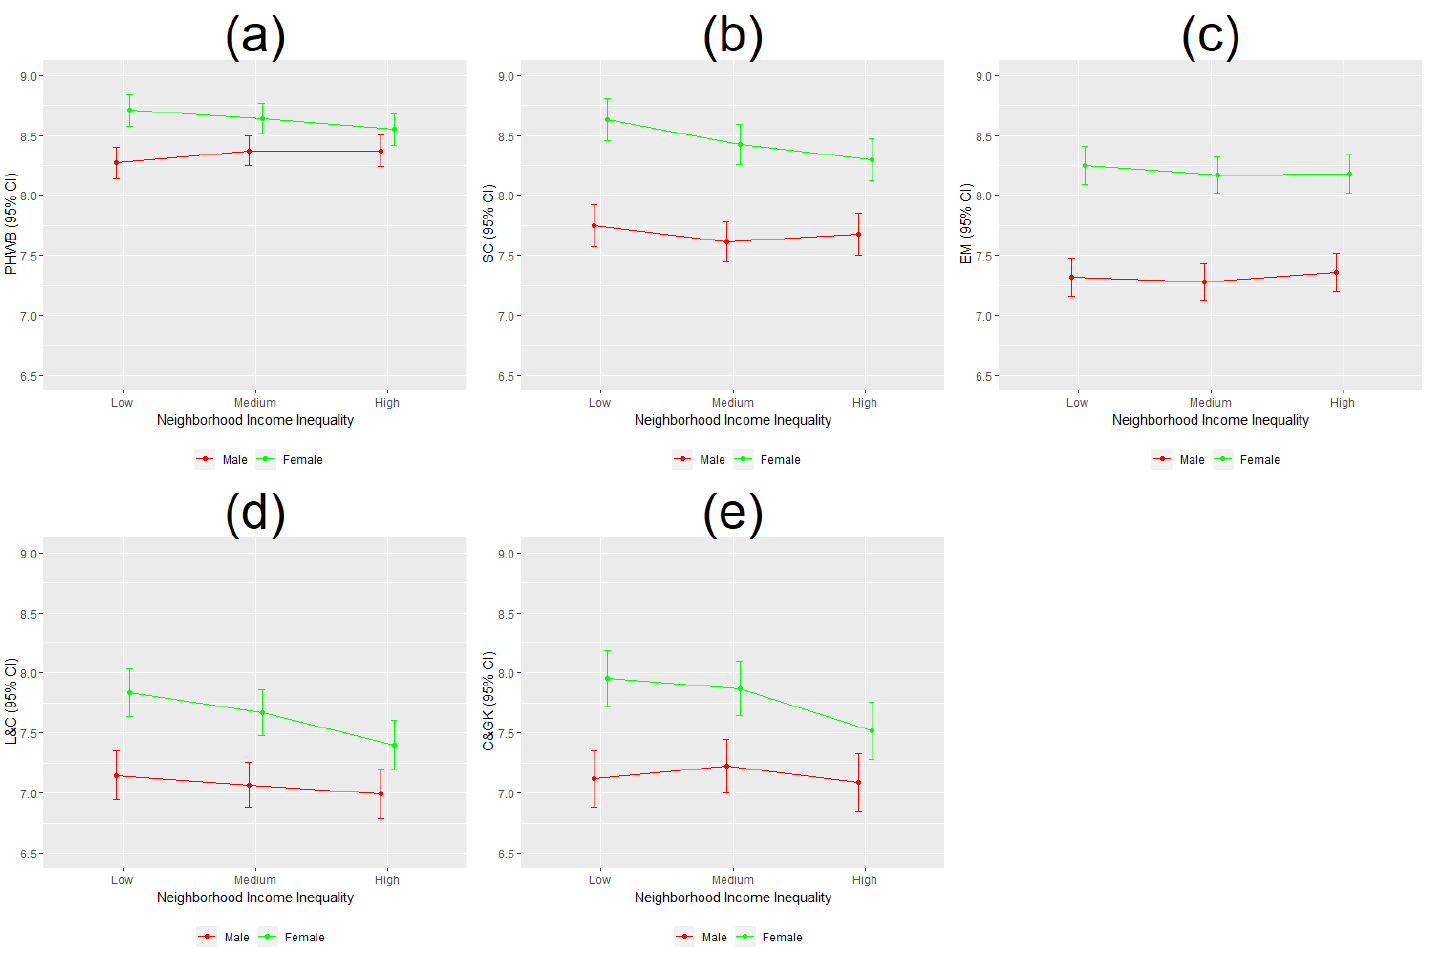
Figure 4. Predicted EDI scores by neighborhood income inequality and children’s sex. ( a – e ) show the relationship between low, medium and high neighborhood income inequality and predicted EDI domain scores and 95% confidence intervals are di ff erent for male versus female children. PHWB: physical health and well-being; SC: social competence; EM: emotional maturity; L & C: language and cognitive development; C & GK: communication and general knowledge.